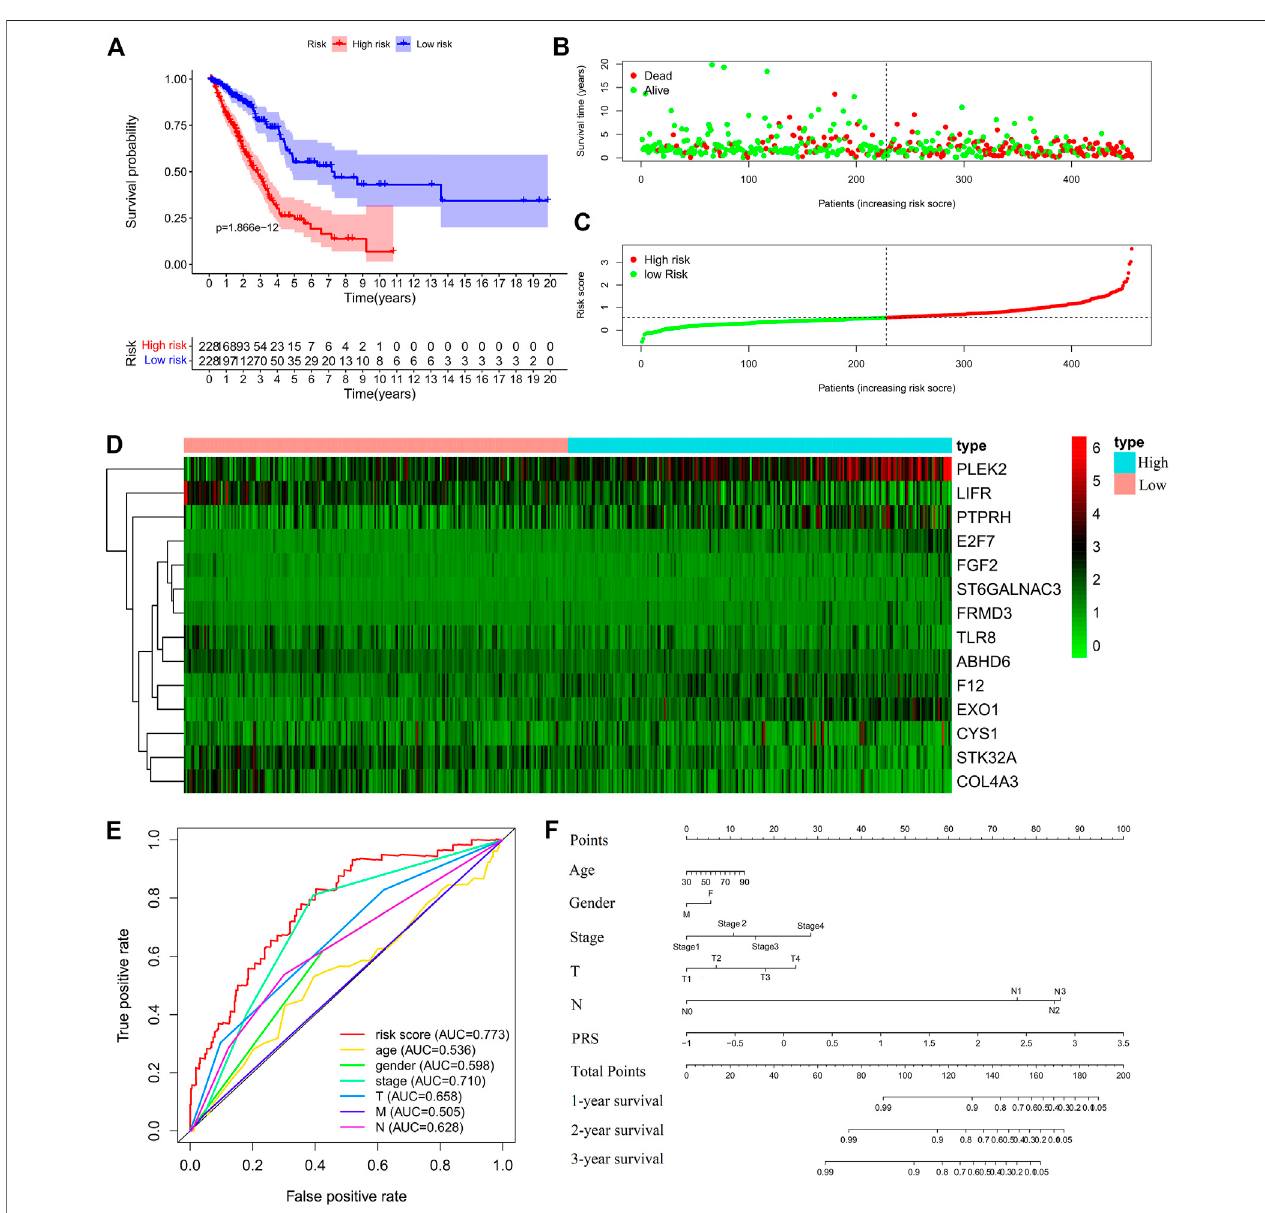
FIGURE 3 | Construction of the prognostic risk score (PRS) model in the training set. (A) Comparisons of OS between the high- and low-risk groups. (B) . Distribution of survival time of patients with different outcomes; (C) Distribution of increasing risk scores in high- and low-risk groups; (D) Heatmap of the fourteen-gene expression pro fi les in high- and low-risk groups; (E) ROCs of models with gender, stage, tumor size (T), lymph node metastasis (N), distant metastasis (M), and PRS as variables, respectively; (F) Nomogram to predict the 1-year, 2-years and 3-years survival rates of the patients in the training set by using gender, stage, tumor size (T), lymph node metastasis (N), distant metastasis (M), and risk score as variables,